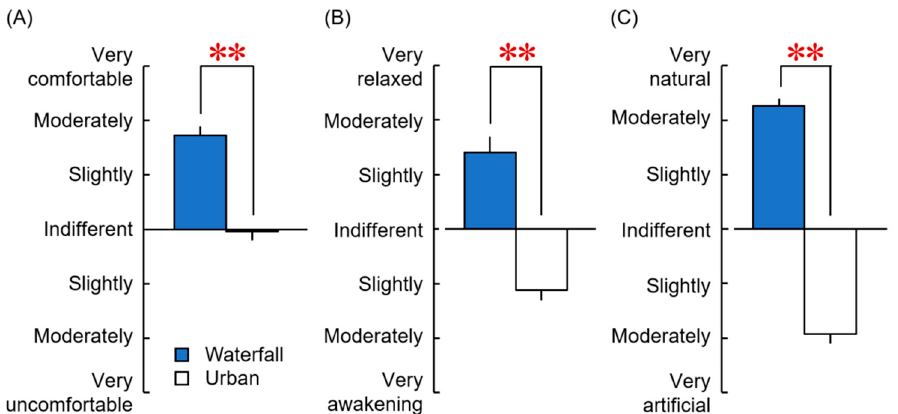
Figure 5. Psychological effects were evaluated using the modified SD method based on three opposing adjective pairs after viewing the waterfall and urban images. ( A ) Comfortable vs. uncomfortable. ( B ) Relaxed vs. awakening. ( C ) Natural vs. artificial ( n = 27, mean ± standard error). ** p < 0.01 (waterfall vs. urban). Wilcoxon signed-rank test.